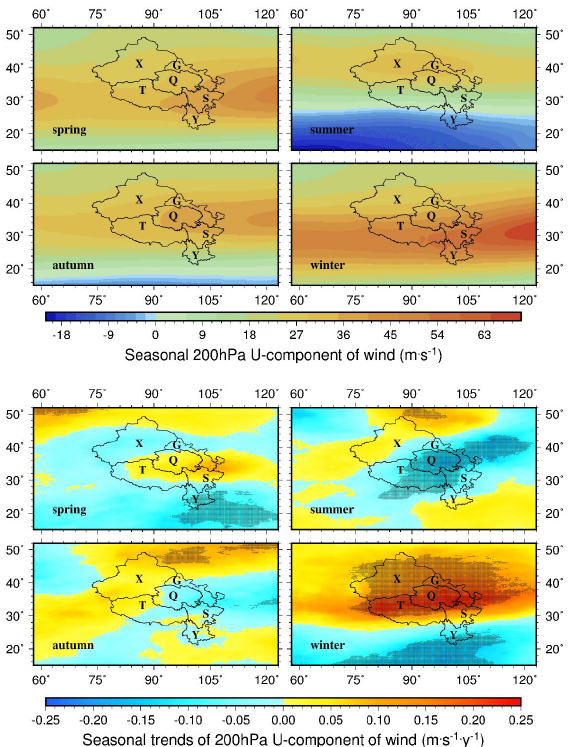
Figure 13. Spatial distributions of the means and trends of U-component wind at 200 hPa (Ucw200) during 1979–2015. Negative values represent westward wind. The above analyses are consistent with what the vertical integrals of northward water vapor flux (Figure S5 of the Supplementary Materials) and eastward vapor flux (Figure S6 of the Supplementary Materials) reveal. Specifically, decreasing trends in both fluxes are seen over the southeast in summer and autumn while increasing trends in both fluxes are seen over the TPS in winter and over the central to northwestern TPS in summer and autumn. The weakening of the southerly and westerly in the southeast in summer is con- sistent with the weakening of the Asian summer monsoons and the westerly jet while the strengthening of the westerly over the TPS in winter is in line with the strengthening of the wester jet (Table 3).